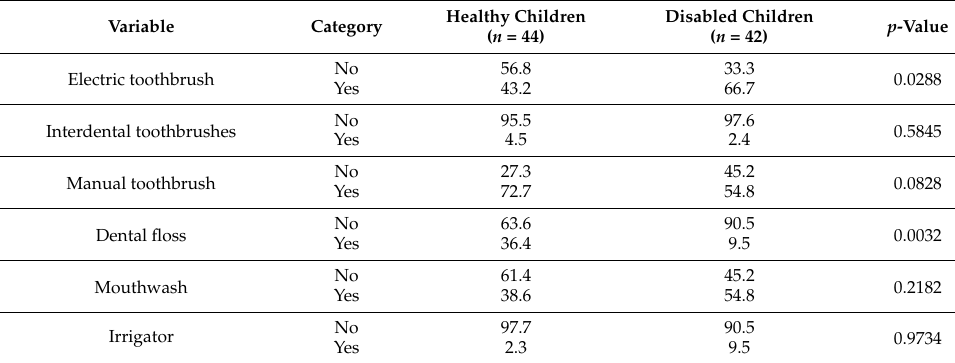
Table 2. Oral hygiene behaviours of healthy and disabled children.